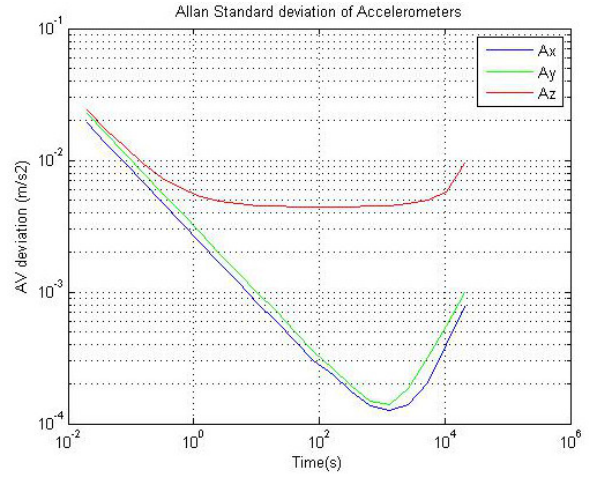
Figure 2: Allan variance for the MAXIM accelerometers